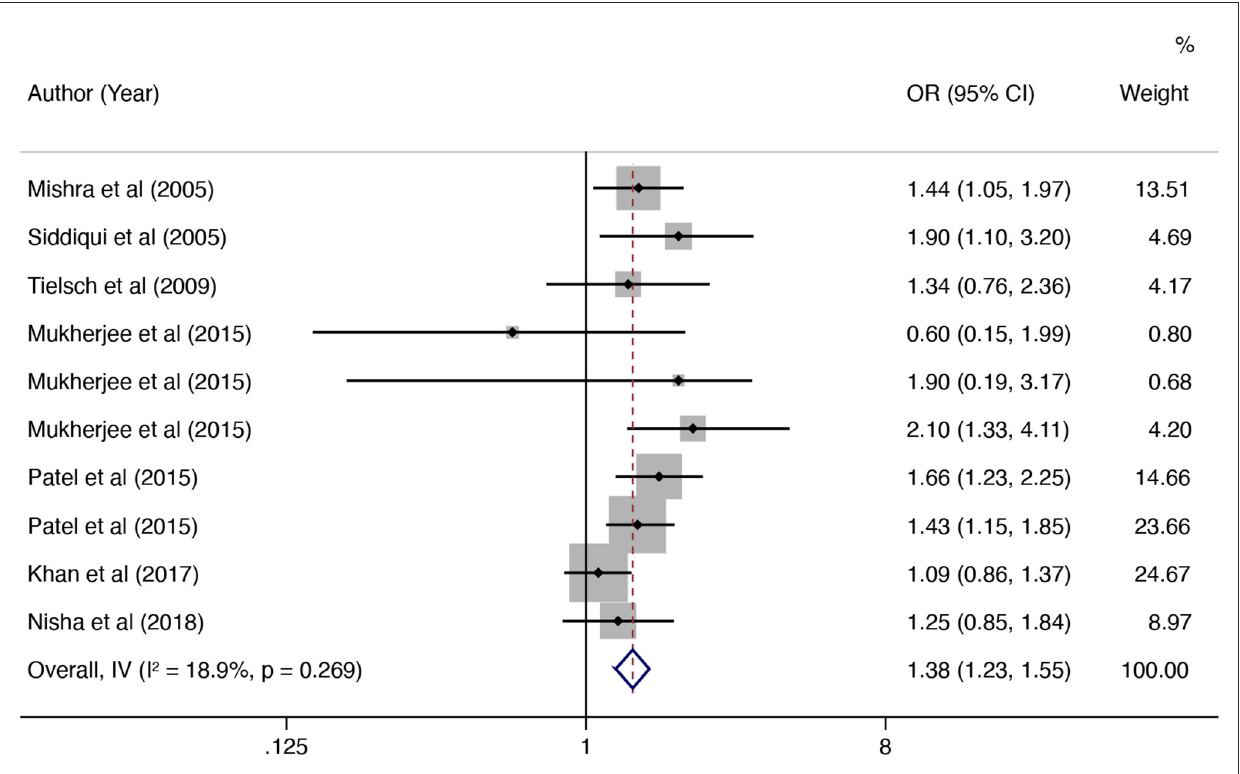
FIGURE4 Forest plot showing the effect of polluting cooking fuels on stillbirth.